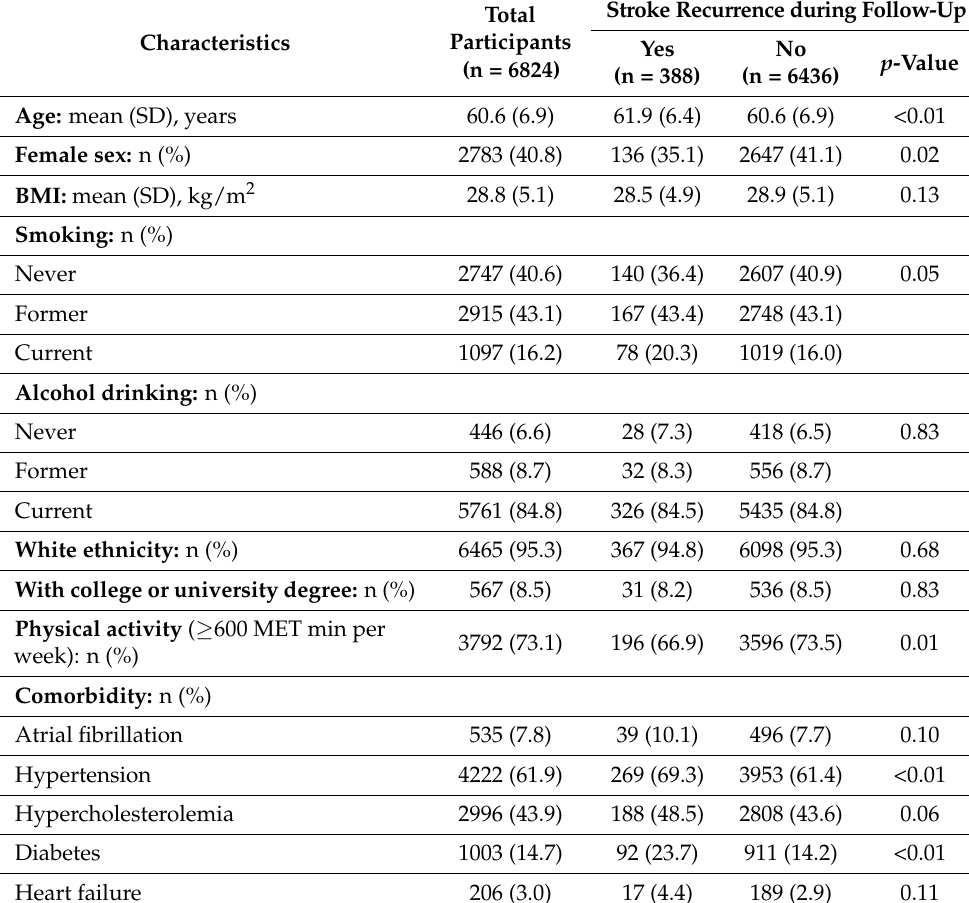
Table 1. Patients’ baseline characteristics and comparisons between patients with and without recurrent